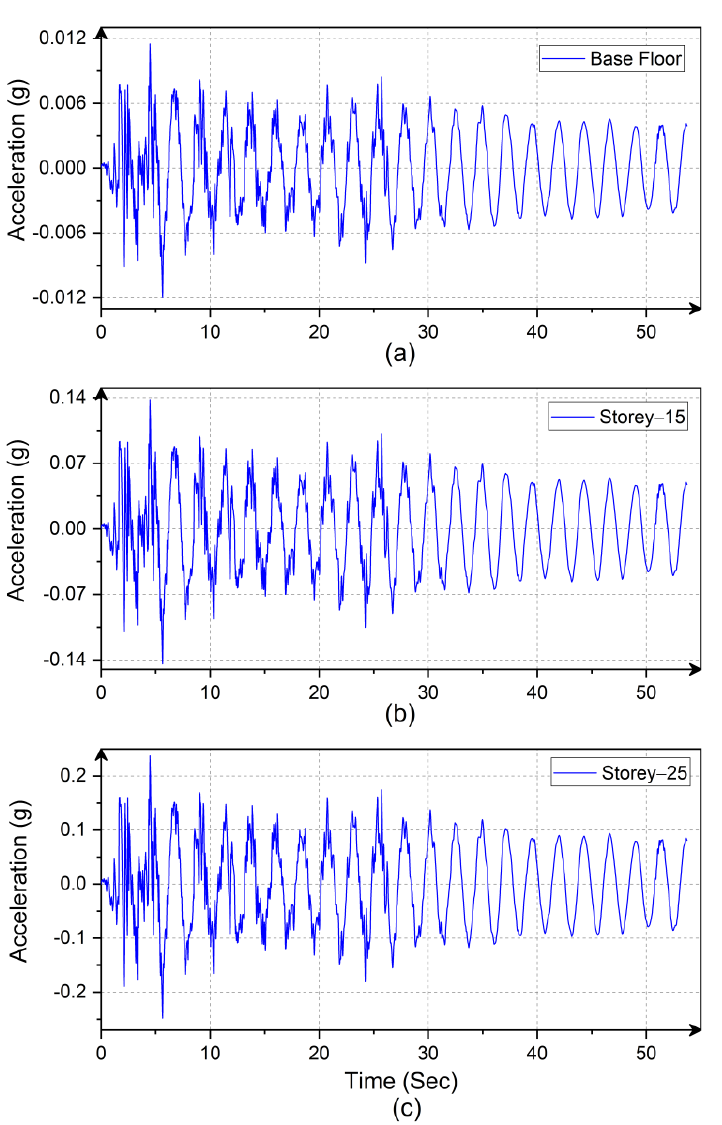
Figure 7. Acceleration (time–history) plots of the various story levels of the building: ( a ) Base Floor; ( b ) Story-15; and ( c ) Story-25.